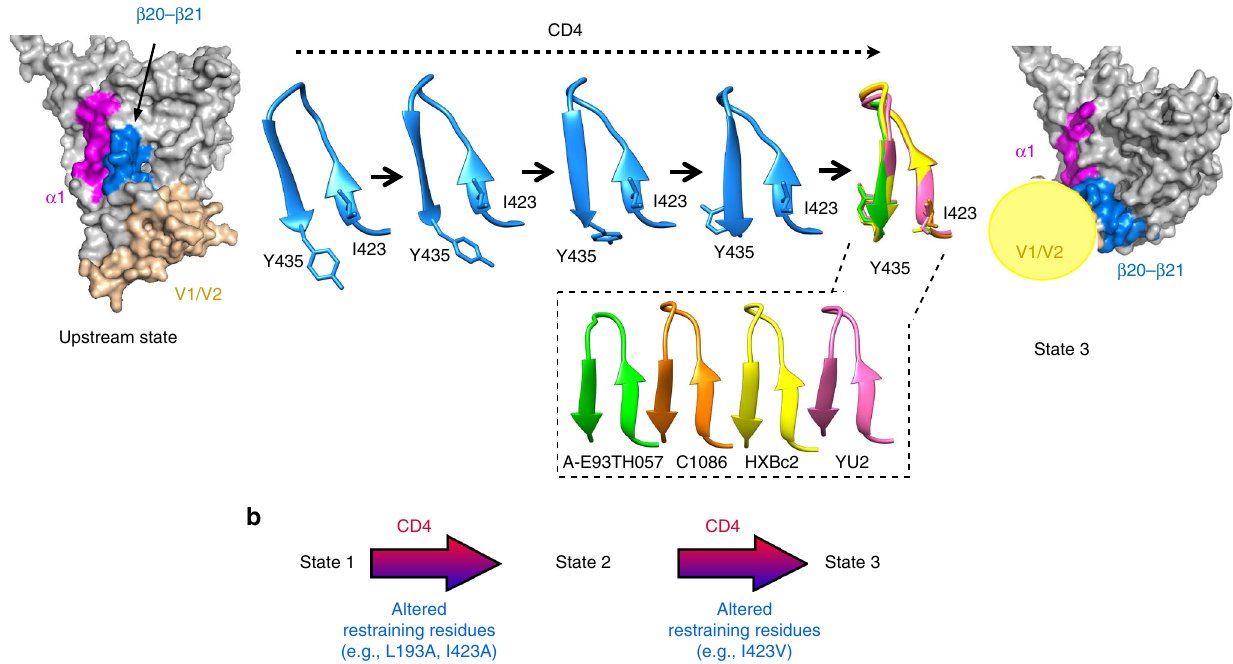
Fig. 7 Model of HIV-1 Env conformational regulation. a Changes in the β 20 – β 21 conformation upon CD4 binding. Left, surface representation showing the location of the β 20 – β 21 element in one gp120 subunit on the HIV-1 Env structure; the ribbon structure of β 20 – β 21 is depicted to the right of the Env surface. Both representations are derived from the crystal structure of the HIV-1 BG505 sgp140 SOSIP.664 glycoprotein (PDB ID 4TVP) 30 . Right, surface representation from the cryo-EM structure of HIV-1 BG505 sgp140 SOSIP.664 bound to sCD4 (PDB 5THR; the V1/V2 region is shown schematically as a yellow sphere). The β 20 – β 21 elements from four crystal structures of gp120 from different HIV-1 clades bound to sCD4 or the DMJ-II-121 CD4-mimetic compound (PDB IDs 4I53, 4I54, 1GC1, and 1RZK) are aligned. A possible trajectory between the upstream state and the CD4-bound state was